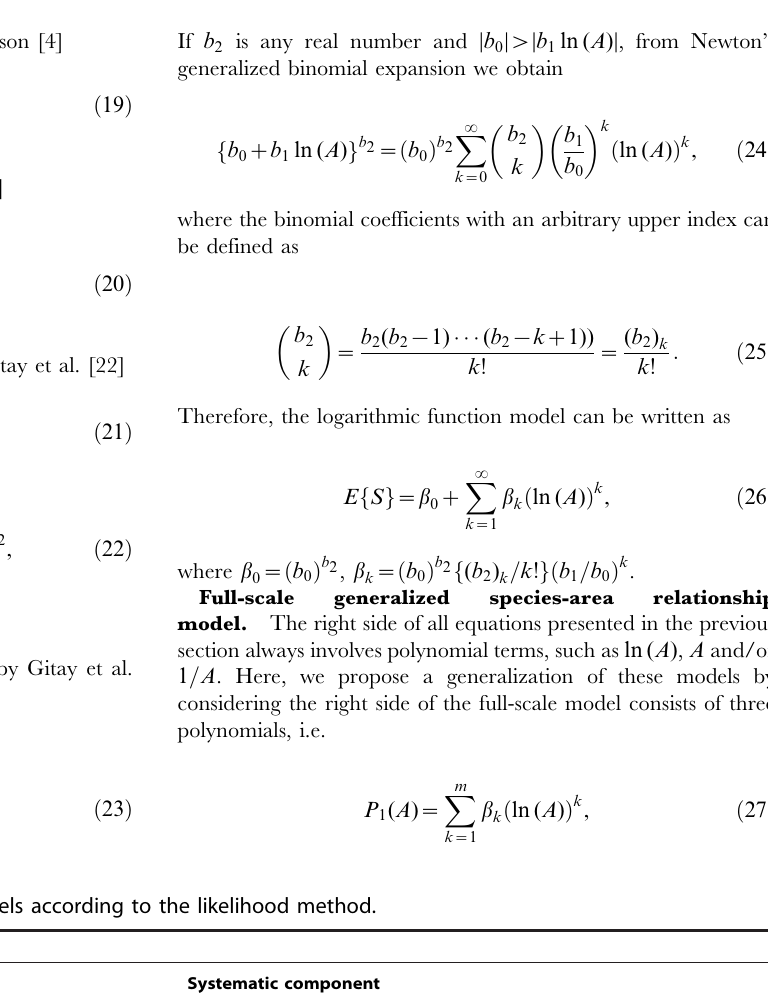
Models Systematic